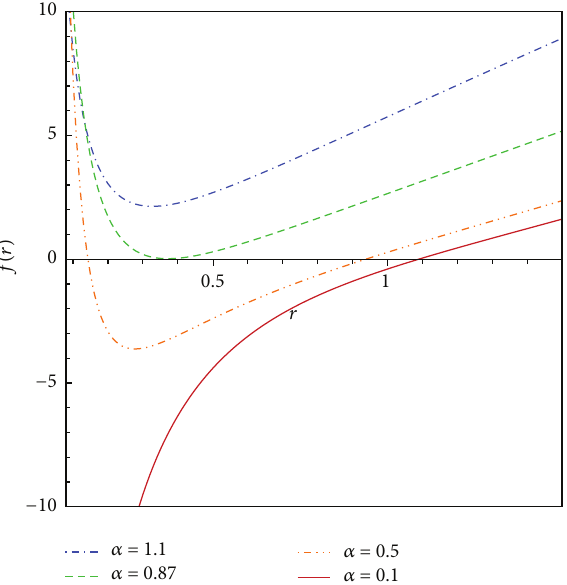
Figure 1: The behavior of 𝑓(𝑟) versus 𝑟 with 𝑙 = 𝑏 = 1 , 𝑞 = 0.5 , Ξ = 1.25 , 𝑛 = 5 , 𝛽 = 2 , and 𝑚 = 1.5 .